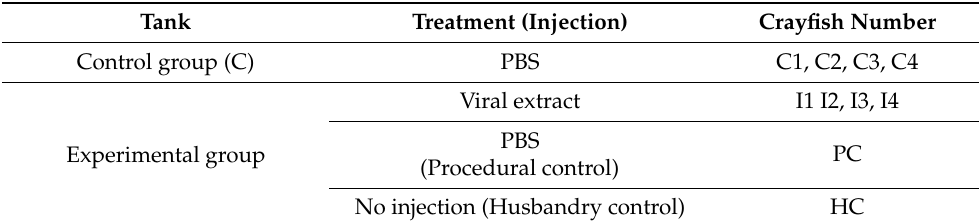
Table 2. Design for Experiment